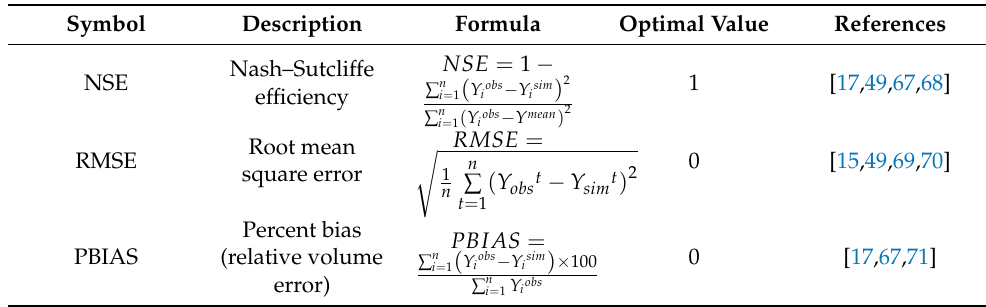
Table 4. Performance measures matrix.